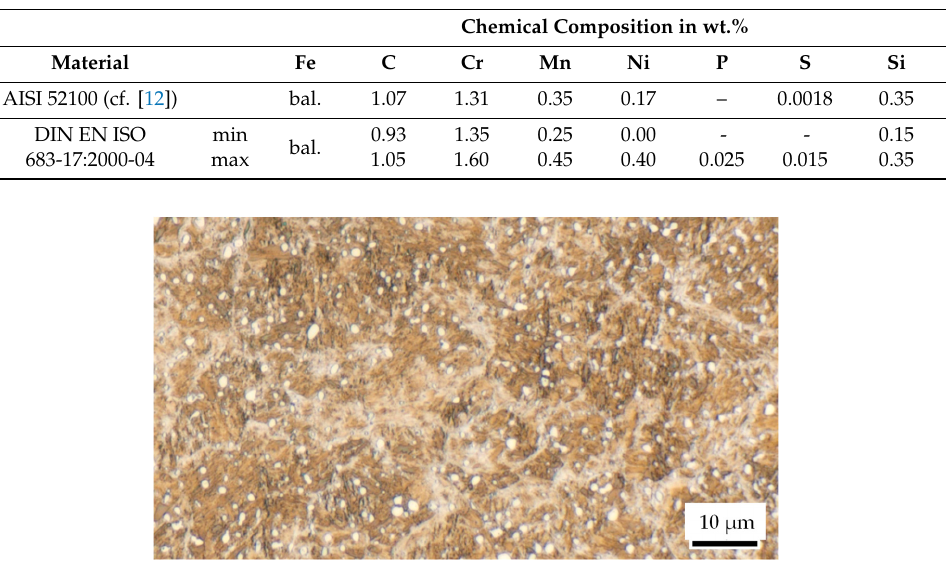
Figure 2. Microstructure of the microscopic samples after the roller ball production process; etched 25–30 s in 3% alcoholic HNO 3 , equatorial cut.